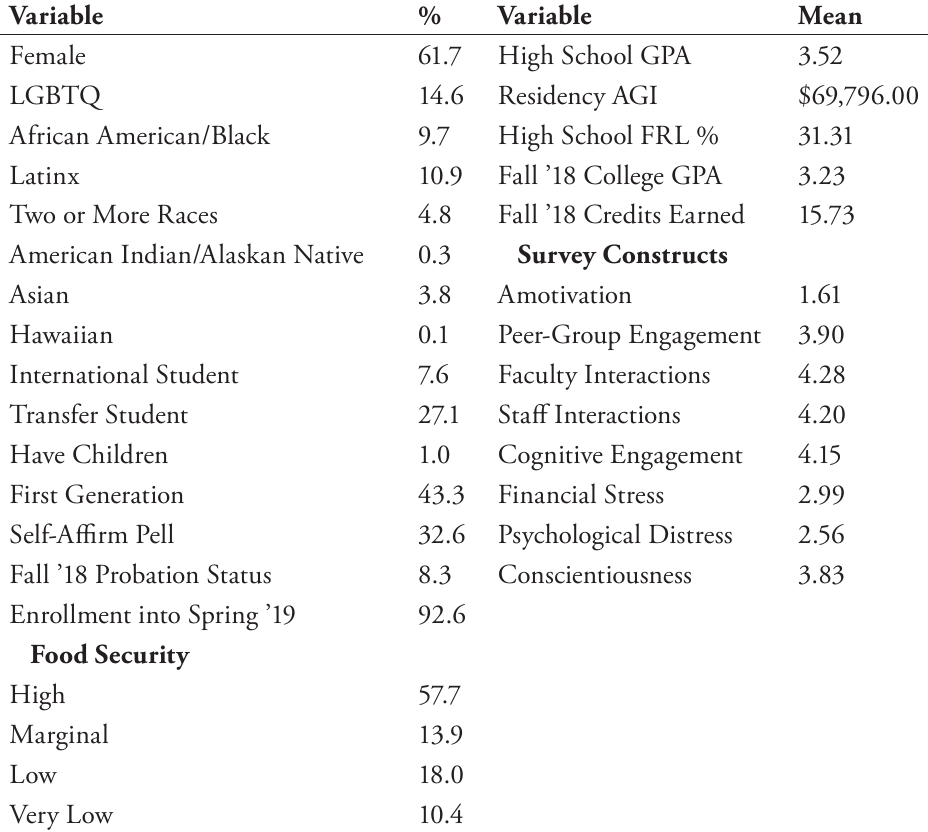
Table 1. Respondent Sample Percentages and Means